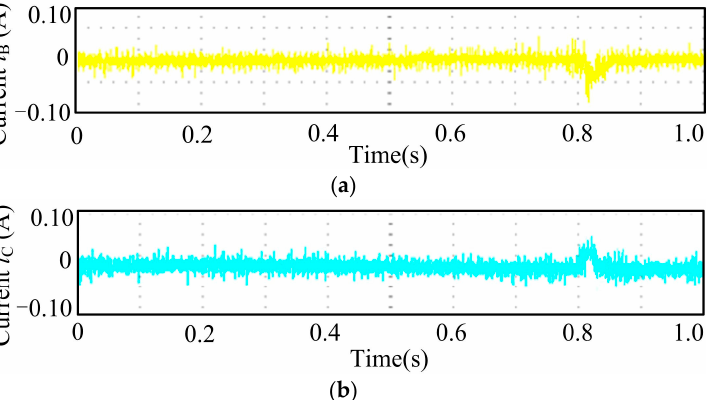
Figure 15. Control current waveforms in accelerated experiment. ( a ) B-phase control current i B . ( b ) C-phase control current i C .